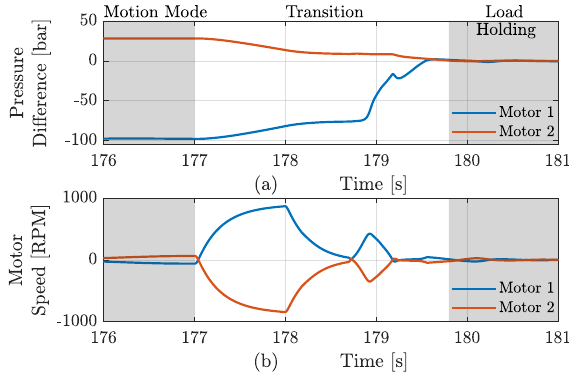
Figure 21: (a) Pressure difference across pumps during mode transition and in load holding mode. (b) Shaft speeds during mode transition and in load holding